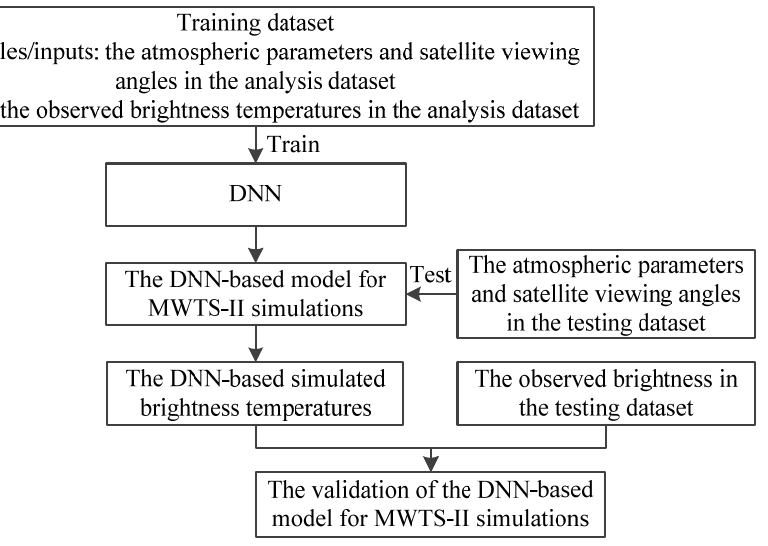
Figure 2. The schematic of building the DNN-based model for MWTS-II